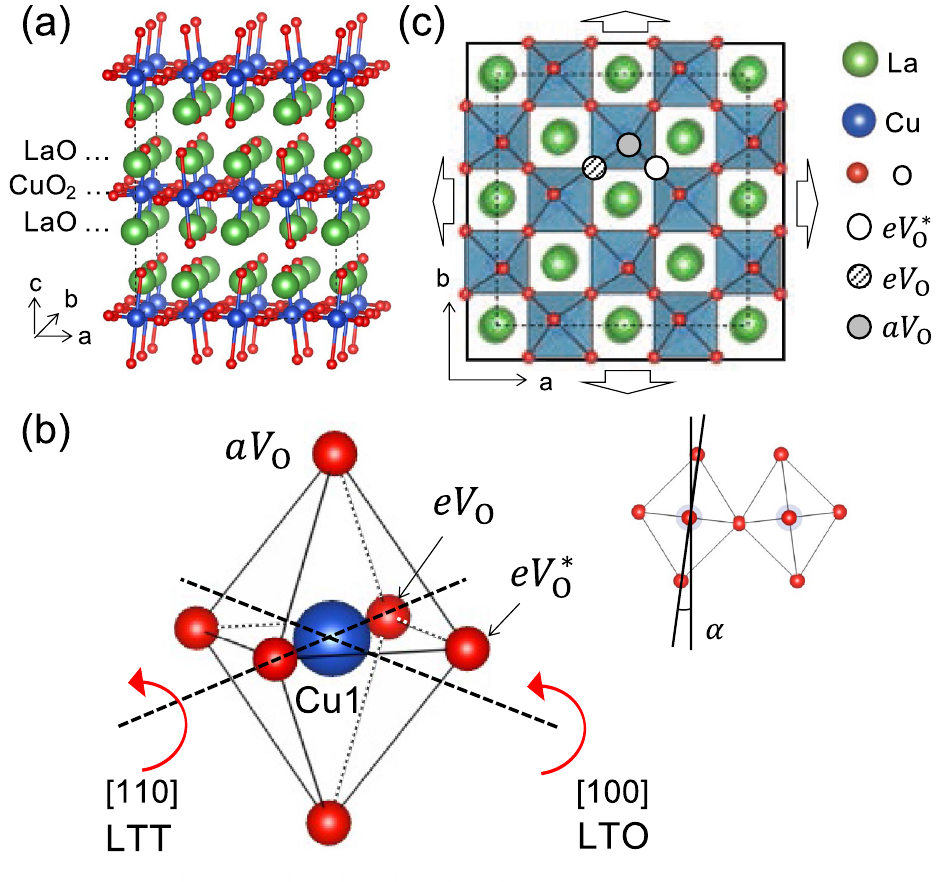
R 45 ◦ 2 √ 2 2 structure composed of 16 formula units. The green, blue, and Figure 1. ( a ) La 2 CuO 4 (cid:31) 2 √ 2 (cid:30) × × red balls represent lanthanum, copper, and oxygen atoms, respectively. ( b ) Two kinds of low-temperature phases are distinguished by the axis of octahedron tilt as indicated with red arrows. For LTT phase, CuO 6 octahedron is tilted along [110] axis while for LTO phase, the tilting axis becomes [100]. Three inequivalent oxygens are indicated. α is tilting angle of the octahedron and its experimental and calculational values are listed in Table 1. ( c ) Top view of the LTT phase. White, hatched and gray circles are inequivalent locations of oxygen atoms termed as equatorial*( eV O * ), equatorial ( eV O ) and apical site ( aV O ). Arrows indicate the applied uniform biaxial strain (the same scaling of lattice constant a and b